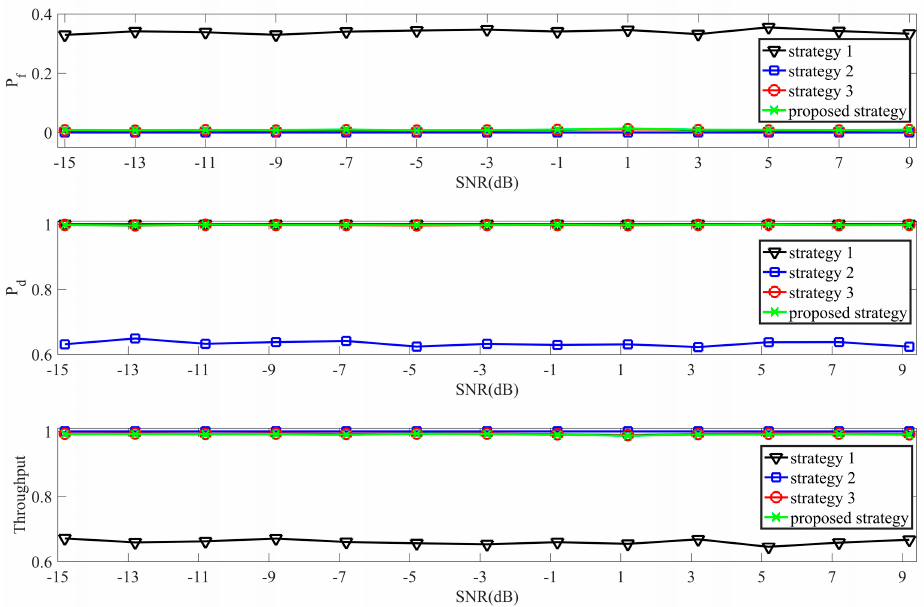
Figure 1. Comparisons between three classical sensing strategies and the proposed sensing strategy when N = 100.